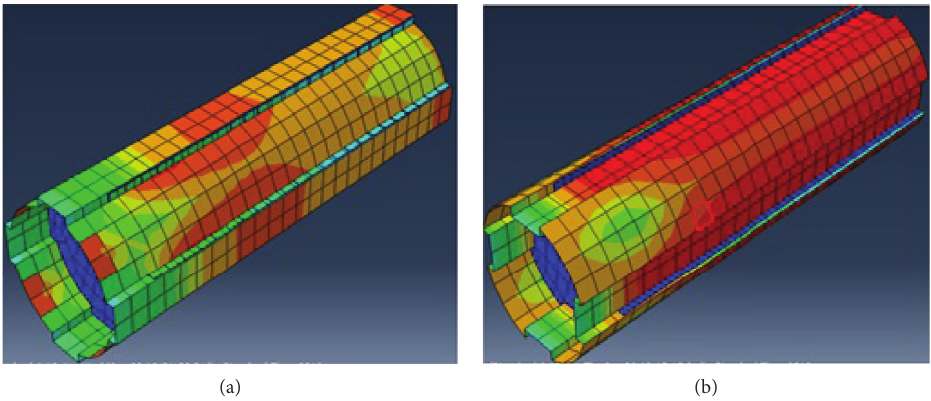
Figure 6: Deformed shapes: (a) outward fluted section; (b) inward fluted